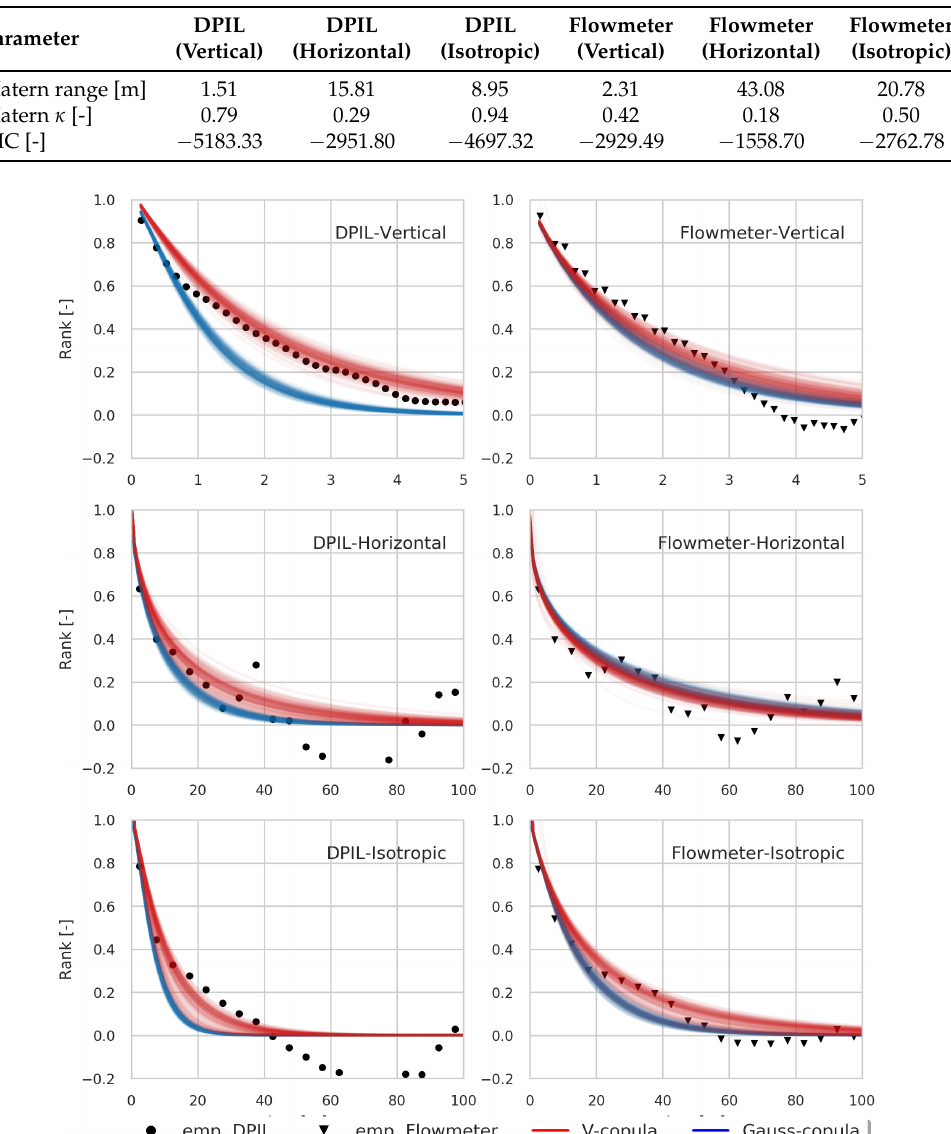
Figure 10. Comparison between empirical rank correlation (black dots) and the theoretical bivariate copula rank correlations of model fitting results by gauss- (blue line) and v-copula (red line) model of DPIL ( left ) and flowmeter dataset ( right